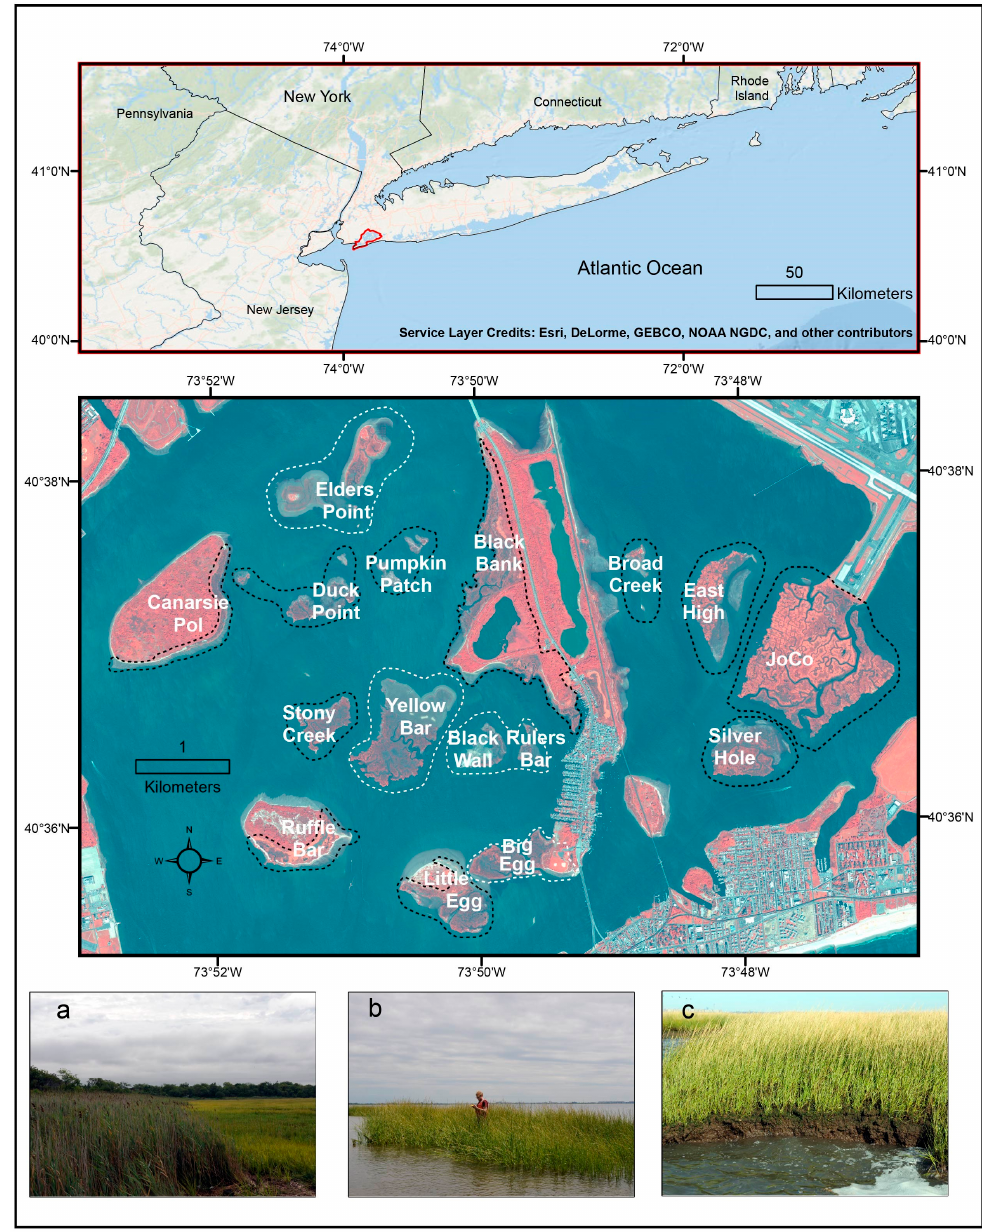
Figure 1. The study area of Jamaica Bay, NYC, includes salt marsh islands as labeled on top of the pseudo color display of 2012 Worldview-2 imagery (NIR-1, G, B in RGB). Field photos illustrate: ( a ) the transition from Phragmites australis to salt marsh; ( b ) Isolated S. alterniflora patch; and ( c ) S. alterniflora 50%–100% cover. Salt marshes that have been restored at some point are indicated by a white border.